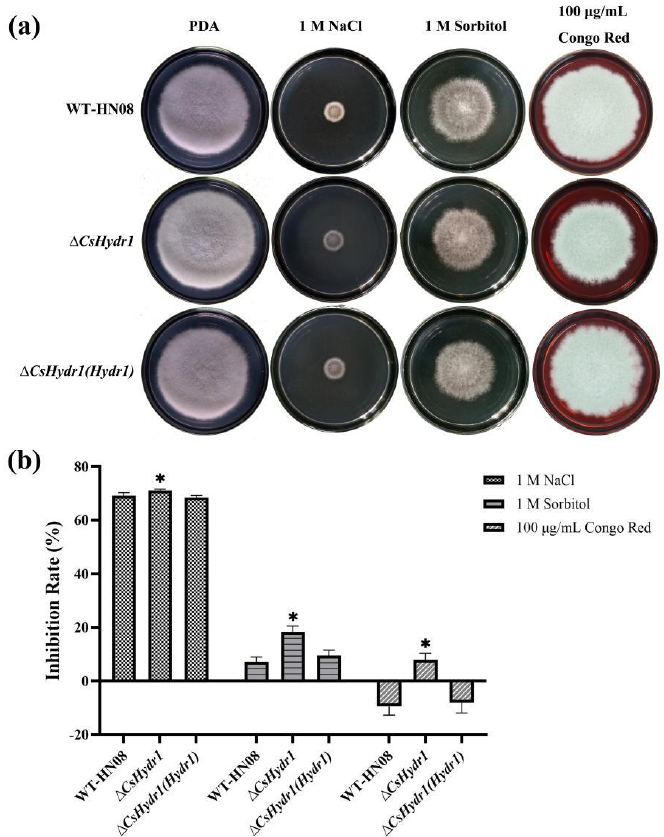
Figure 2. Response of CsHydr1 mutants to various stress conditions. ( a ) Growth of the tested strains on PDA plates supplemented with 1 M NaCl, 1 M sorbitol and 100 μg/mL Congo Red for 7 days ; ( b ) Growth inhibition rate of the tested strains under various stresses. The inhibition rate of mycelial growth was calculated using the following formula: Inhibition rate (%) = [(control diameter – treated diameter)/(control diameter × 100%)]. Each treatment had three replicates. Error bars represent the standard deviations. * indicated significant differences within each measurement group (p < 0.1, One-way Anova and Duncan's test).